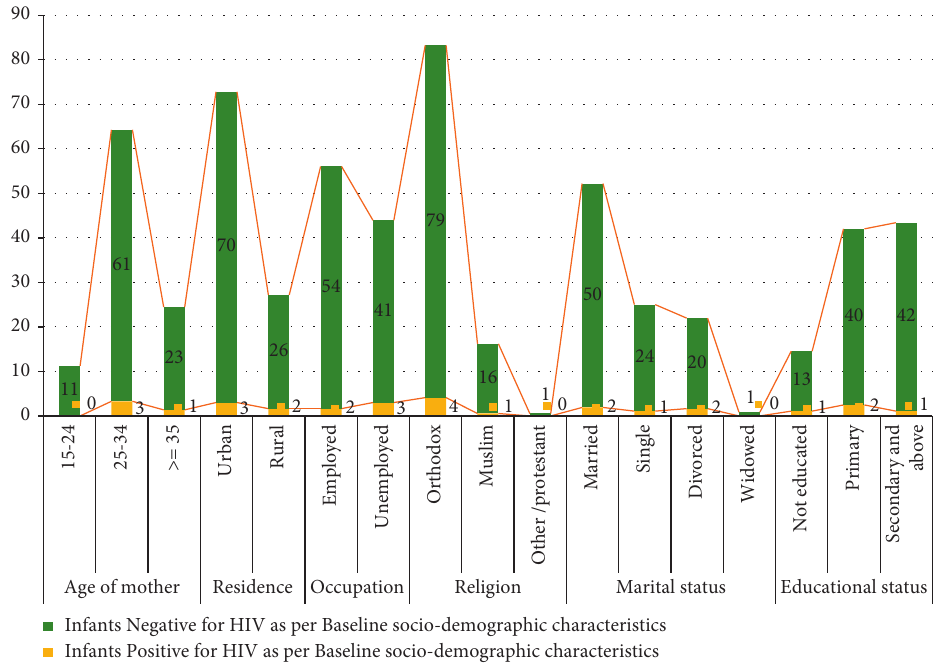
Figure 2: Sociodemographic characteristics of infants with HIV status as per baseline sociodemographic characteristics in selected public general hospitals of West Guji zone, Ethiopia, from March 2019 to March 2021.